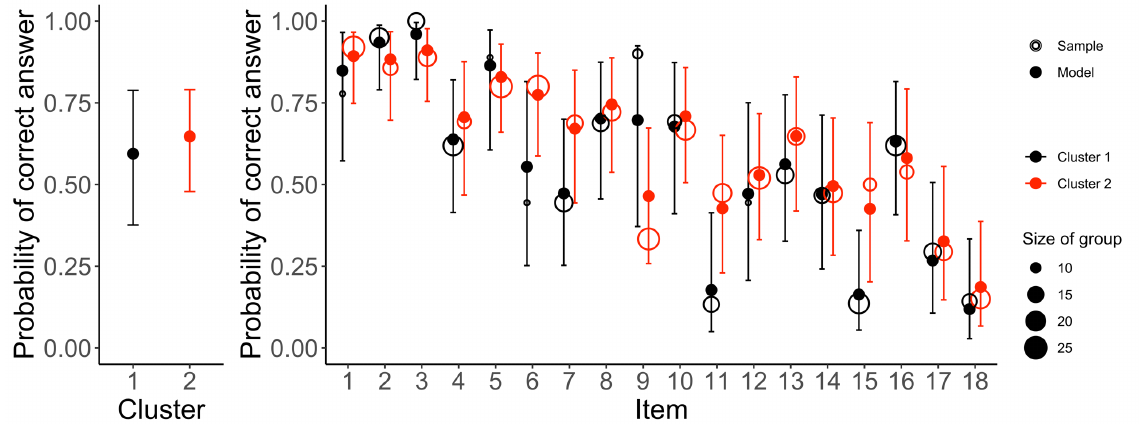
Figure 11. Left panel shows the marginal average probability of a correct answer of each cluster for the two clusters. Right panel shows the probability of a correct answer for each cluster and each item separately. The circles denote the observed proportion of correct answers (and the size of the circle represents the number of data points), whereas dots denote the mean of the posterior distribution. Error bars represent 95% credible